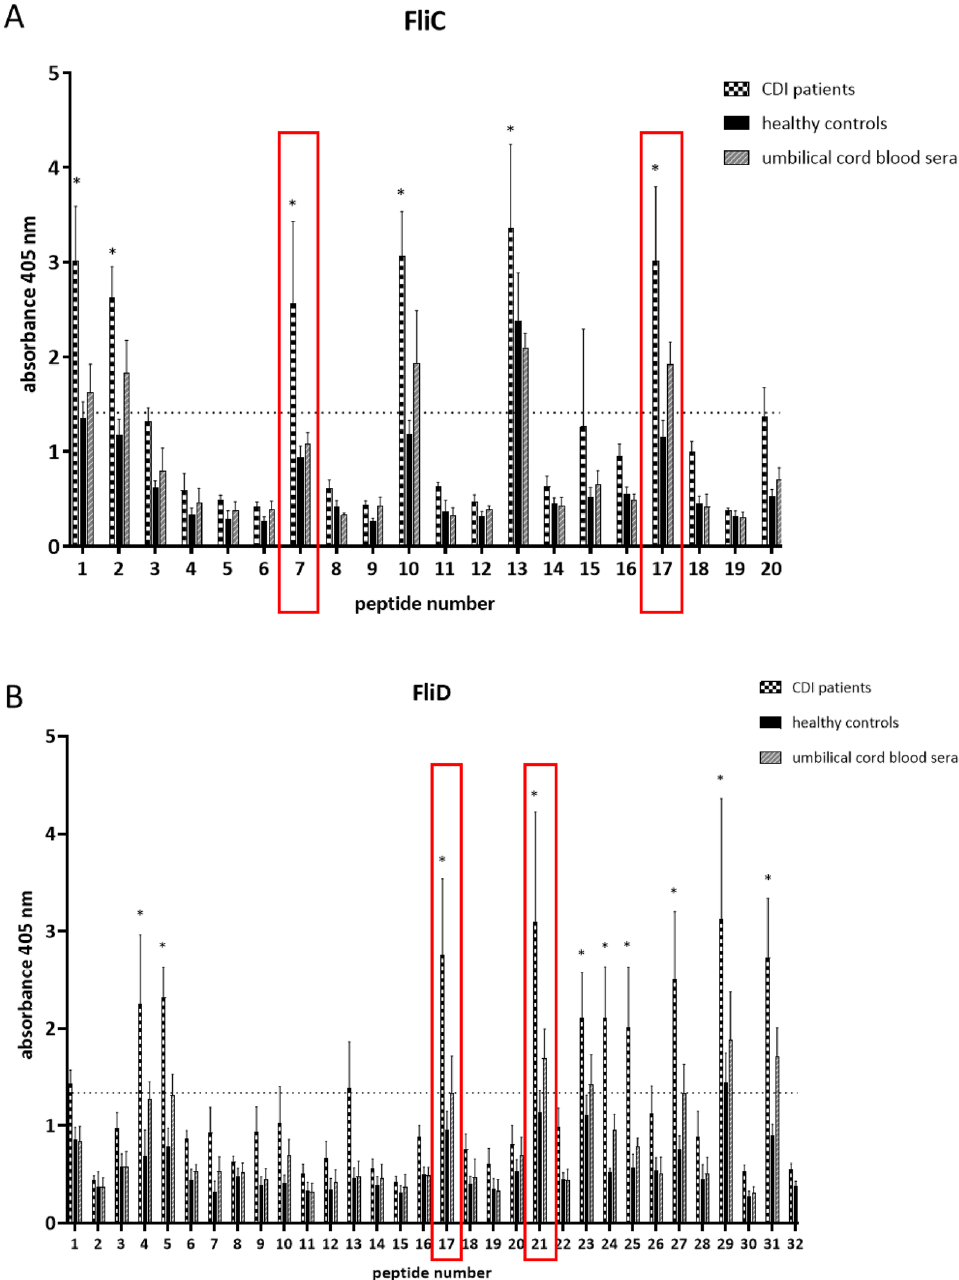
Figure 1. Immunoreactivity of peptides synthesized for mapping FliC ( A ) and FliD ( B ). Immunoreactivity was analyzed by pin-bound ELISA in which three groups of pooled sera: C. difficile -infected patients, healthy controls and umbilical cord blood sera were used in 1:1000 dilution. Anti-human IgG antibody conjugated to AP was used in 1:10,000 dilution. Assay was performed four times, the data shown is mean with ± SD. Statistical significance of the results obtained for C. difficile -infected patient group was calculated using two-way ANOVA in reference to the calculated baseline (1.41 for FliC and 1.34 for FliD) * p < 0.0332. Red brackets indicate peptides selected for further